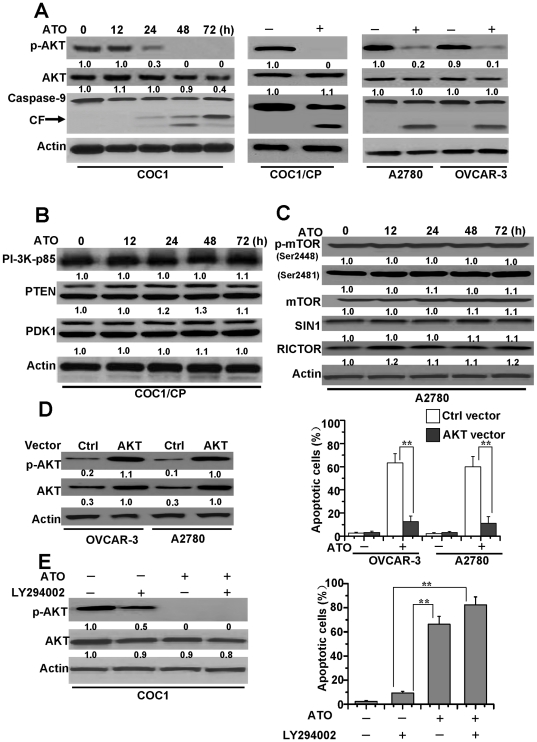
AKT is necessary for ATO-treated cell apoptosis.
A. Detection of AKT phosphorylation, expression and caspase-9 activation. Western blot analysis of total AKT, p-AKT (Ser473) levels and caspase-9 cleavage in COC1 cells. Cells were treated with ATO (2 µM) at different time and lysed in NP40 buffer for detection. CF is referred to cleaved caspase-9. The same detection was employed in COC1/CP, A2780 and OVCAR-3. These cells were treated for 72 h, then lysed and assayed for individual protein levels by Western blot. β-Actin was used as a protein loading control. p-AKT and AKT levels were measured by densitometric analysis of the Western blots and compared to actin levels. Relative amount of p-AKT or AKT from untreated cells was considered as 1. B. Protein levels of the PI-3K signaling pathway in ATO-treated cells. Cells were exposed to drug for different periods of time. Cell lysates were prepared and assayed for individual protein levels by Western blot. Individual protein levels were measured by densitometric analysis of the Western blots and compared to actin levels. Relative amount of individual protein from untreated cells (0 h) was set as 1. C. Effects of ATO on protein levels of mTOR2, including p-mTOR (Ser 2448and 2481), mTOR, RICTOR, SIN1, in A2780 cells. Cells were exposed to drug as described in B, and then cell lysates were assayed by Western blot. Relative amount of protein levels were set as described in B. Cell lysates were assayed by western blot. Relative amount of protein levels were set as described in B. D. Protective effect of constitutive AKT on ATO-induced apoptosis in ovarian cells. OVCAR-3 and A2780 cells were transfected with constitutive AKT1 and were selected for 8 weeks by G-418 and treated with ATO for 72 h. Cells were lysed and assayed for individual protein levels by Western blot. Left, protein levels of p-AKT (Ser473) and AKT (AKT1) in both Ctrl or AKT vector transfected OVCAR-3 and A2780 cells were detected. Relative amount of protein levels were set as described in B. p-AKT and AKT levels of AKT1 transfected A2780 cells were considered as 1. Right, analysis of apoptosis in Ctrl or AKT1 vector transfected OVCAR-3 and A2780 cells. Cell apoptosis was quantitatively detected by a cell death ELISA kit as described in Materials and Methods. All data are depicted graphically as the means ± standard errors of the means for at least three independent experiments. **, P<0.01. E. Detection of the role of LY294002 on apoptosis of cells. Cells were treated with ATO and/or 25 µM LY294002 for 72 h, and then cells were lysed and assayed for individual protein levels by Western blot. Left, protein levels of p-AKT (Ser473) and total AKT in COC1 cells were detected. Cell apoptosis was quantitatively detected by a cell death ELISA kit. Relative amount of protein levels were set as described in B. p-AKT and AKT levels from untreated cells were set as 1. Right, analysis of apoptotic cells as describe in Materials and Methods. All data are depicted graphically as the means ± standard errors of the means for at least three independent experiments. **, P<0.01.